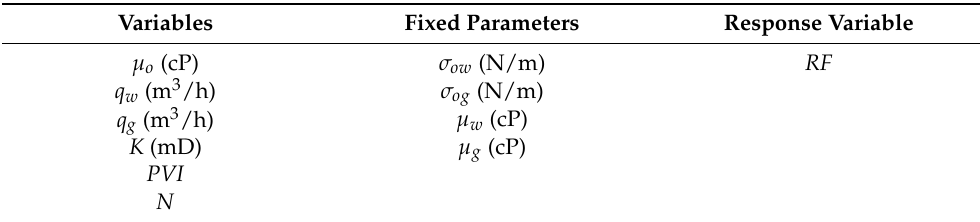
Table 3. Variables needed to develop the dimensionless